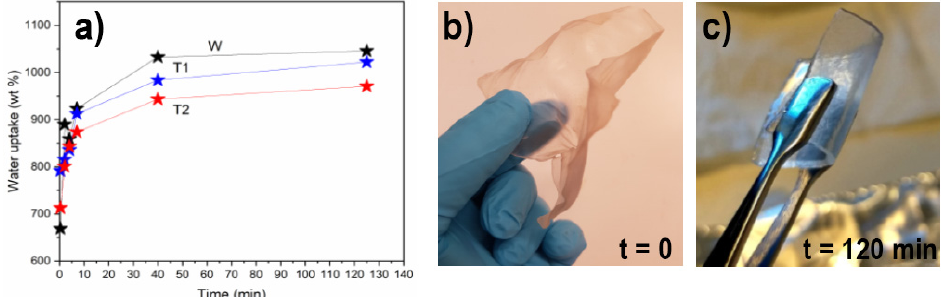
Figure 3 . ( a ) Water uptake as a function of time for hydrogel networks made from the CNF suspen- sions. ( b ) Visual appearance of WT air-dried networks (>90% solid content); ( c ) Rehydrated networks of WT at maximum swelling (<8% solid content).